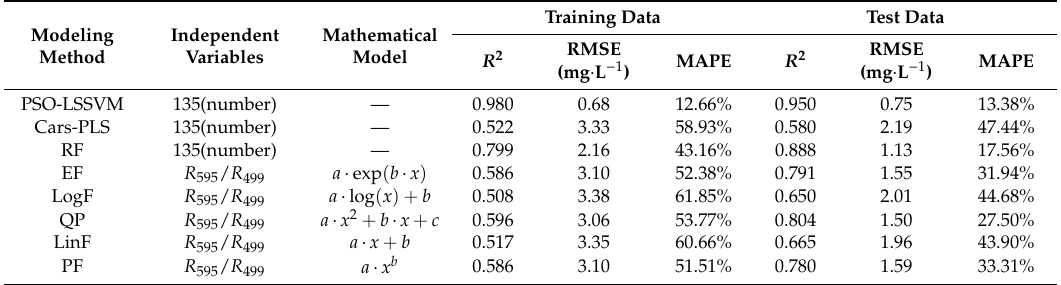
Table 4. Comparison of the di ff erent methods used to build the models for BR